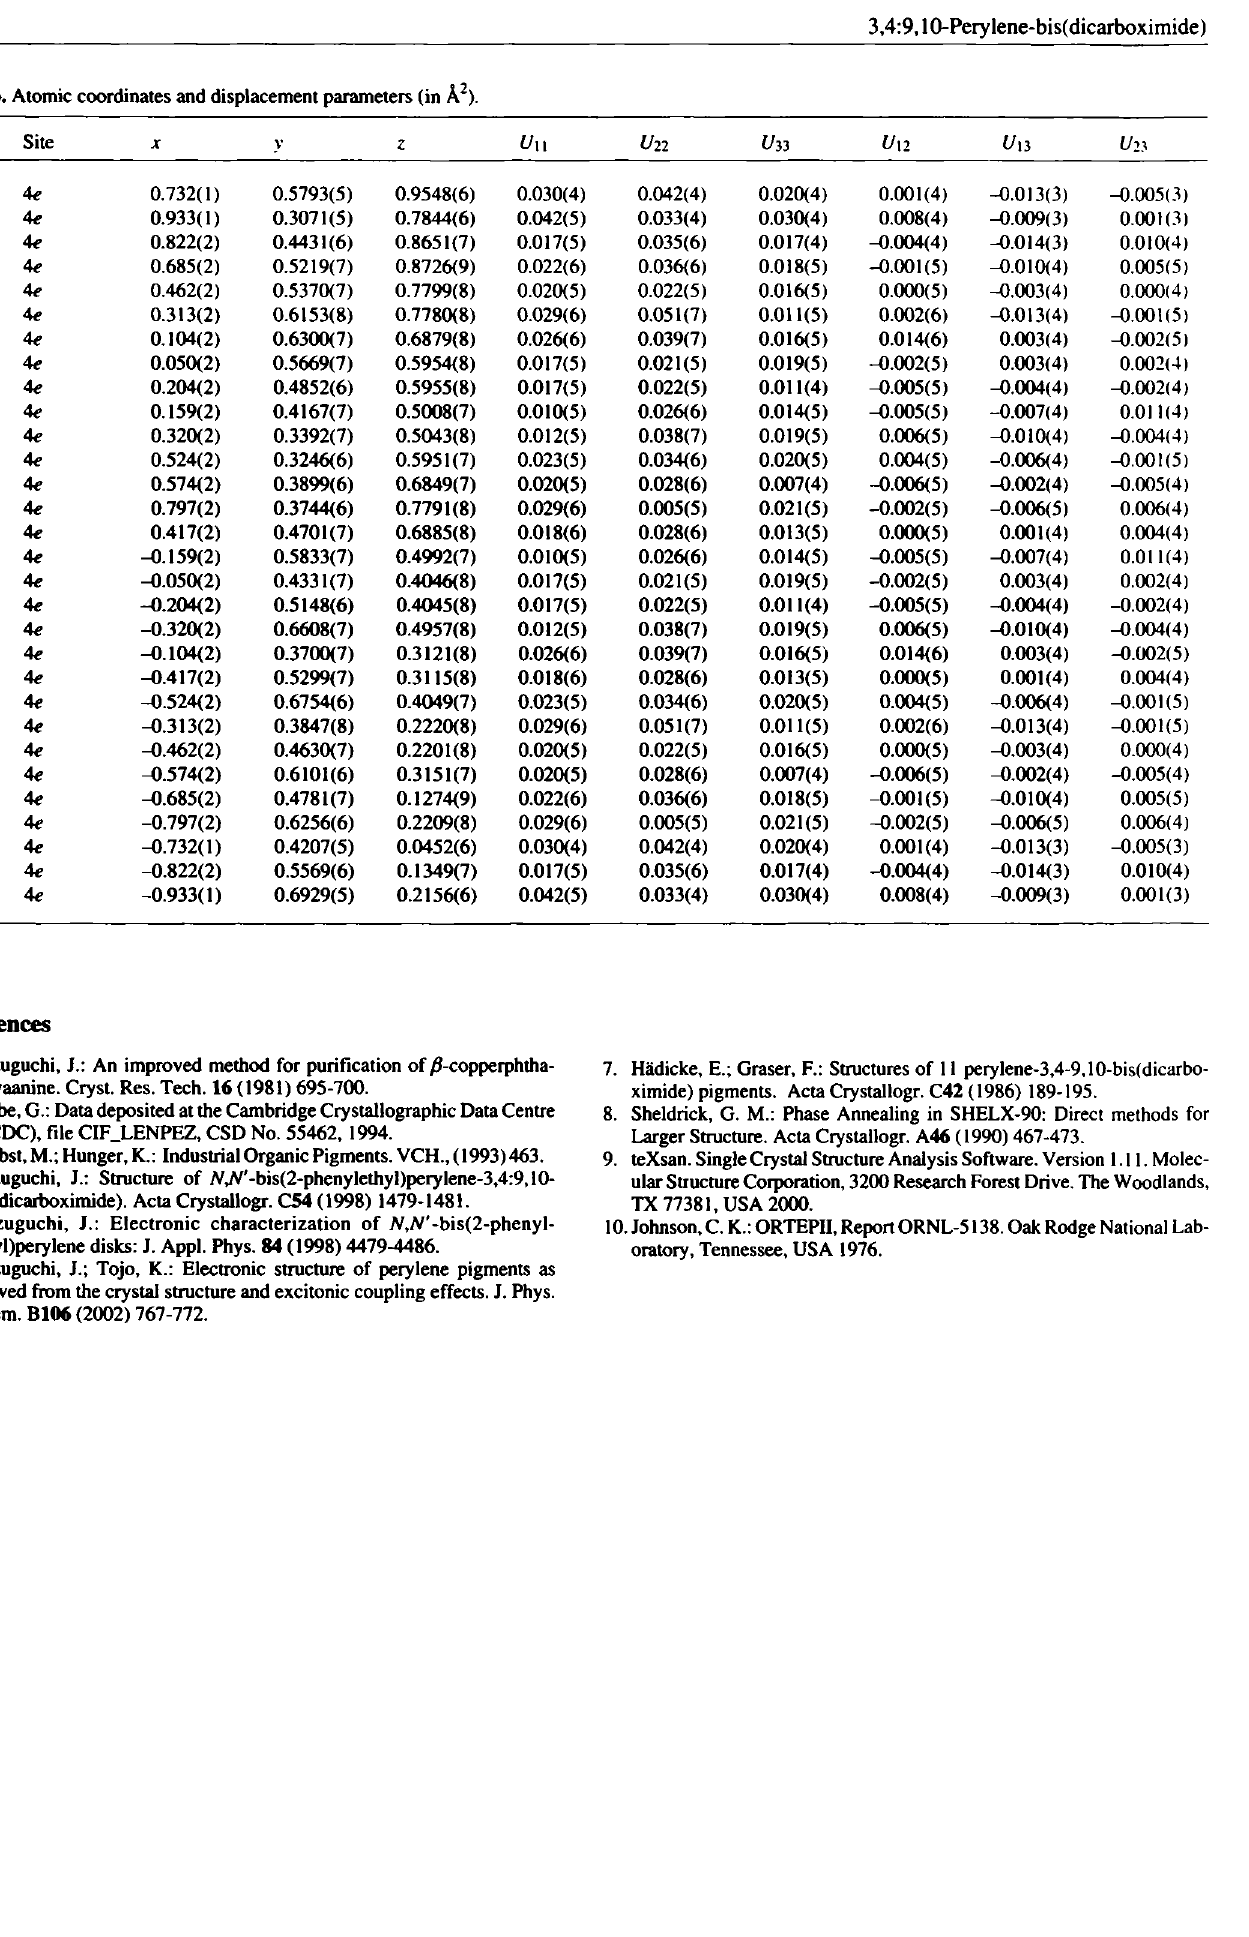
Table 3. Atomic coordinates and displacement parameters (in λ 2